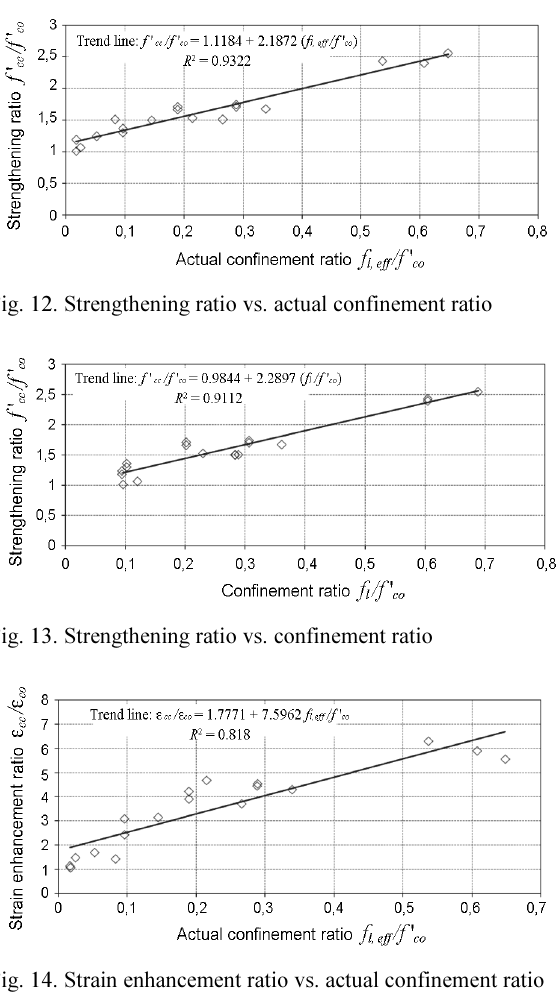
Fig. 14. Strain enhancement ratio vs. actual confinement ratio